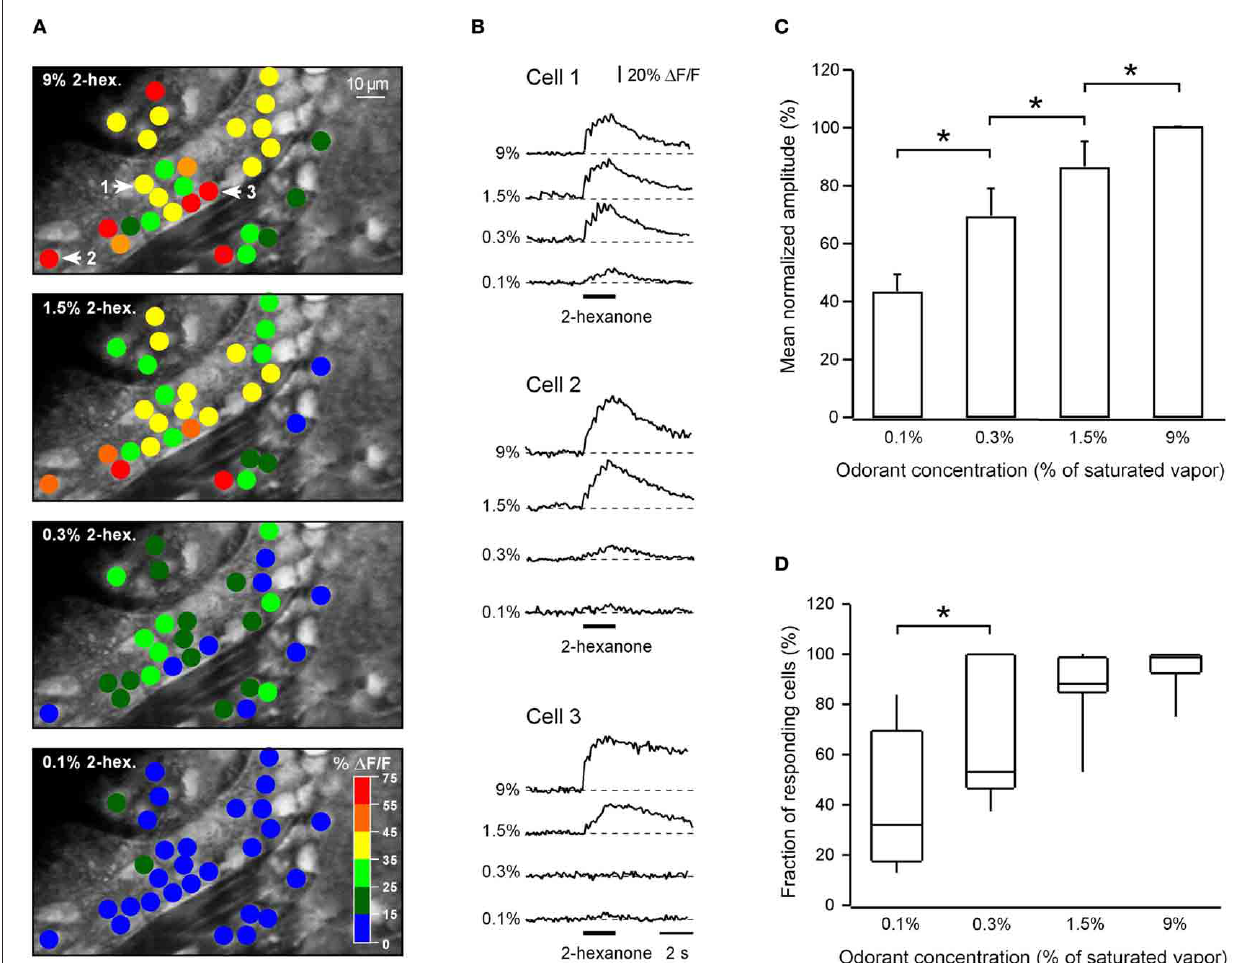
FIGURE 6 | Concentration dependence of odor-evoked calcium signals. (A) ON response activity maps for a single plane of focus at four different odorant concentrations. Peak response amplitudes of Ca 2 + transients of individual cells are displayed using the color code shown in the bottom panel. (B) Odor-evoked Ca 2 + transients recorded from three representative neurons (marked by numbers and arrows in the top panel in A ). Note that neighboring neurons can have very different odorant sensitivity (e.g., cells 1 and 3). The odorant was 2-hexanone. (C) The relationship between the mean normalized amplitude of Ca 2 + transients and the odorant concentration ( n = 441 cells in nine experiments). In each experiment the amplitudes of responding cells